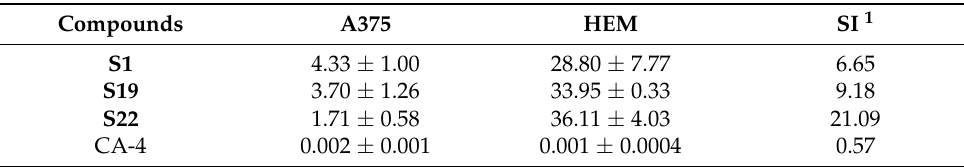
Table 2. Selectivity-index (SI) for selected